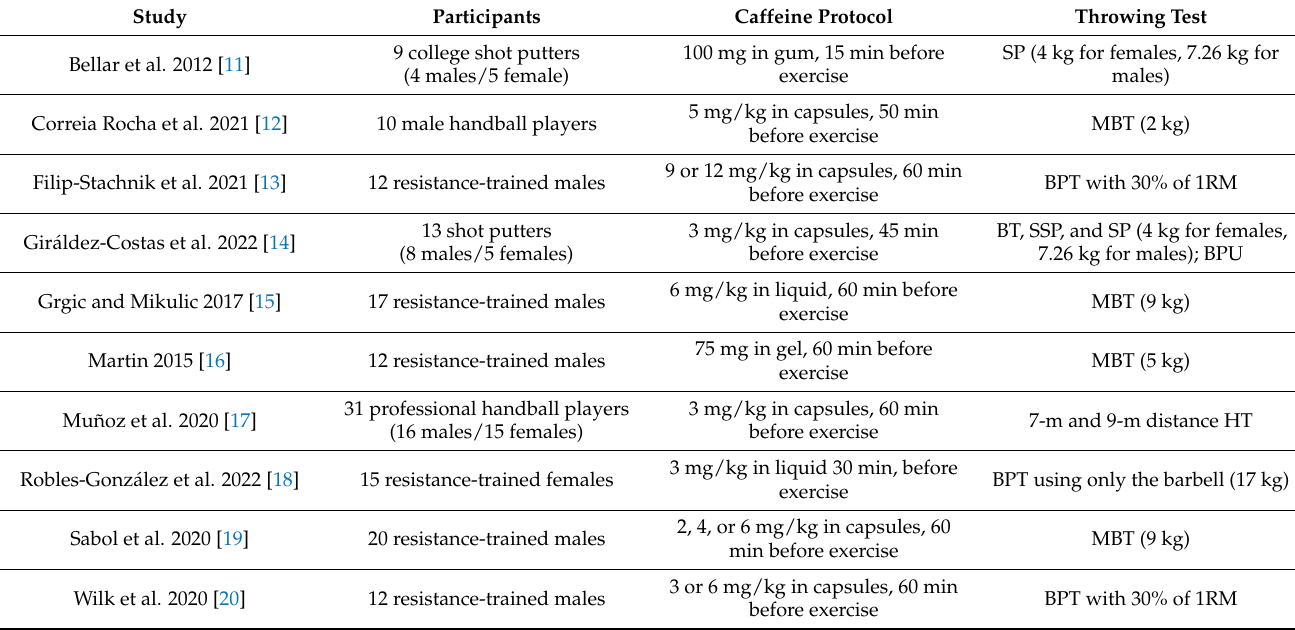
Table 1. Summary of the included studies.